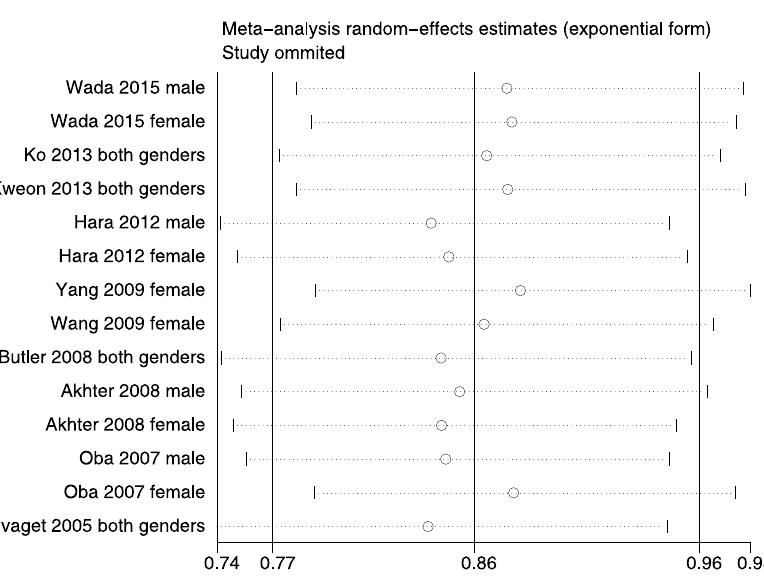
Figure 4. Sensitivity analysis for both genders of soy product intake and incidence of GI